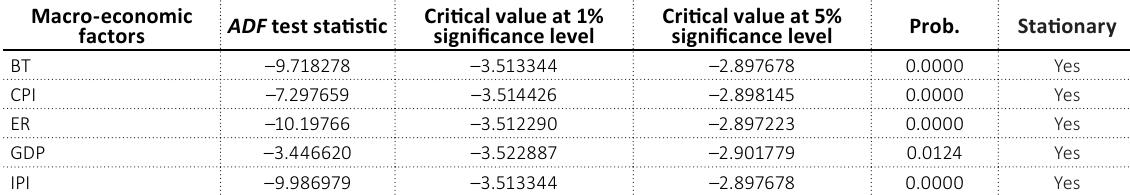
Table 3. Correlation tests results for Palestine market